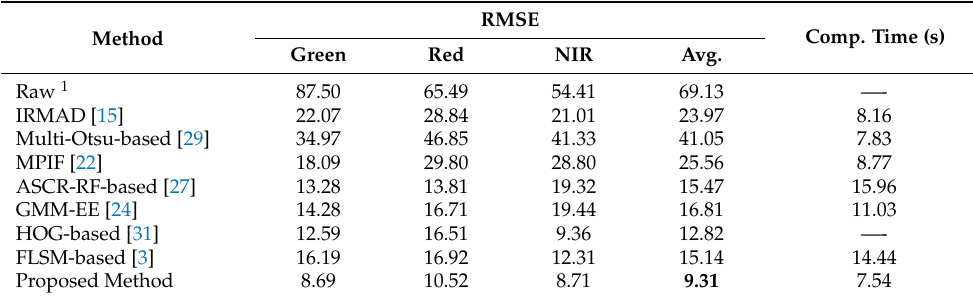
Table 2. Comparison between the accuracy and componential time of different SRRN methods and the proposed method for the simulated dataset.